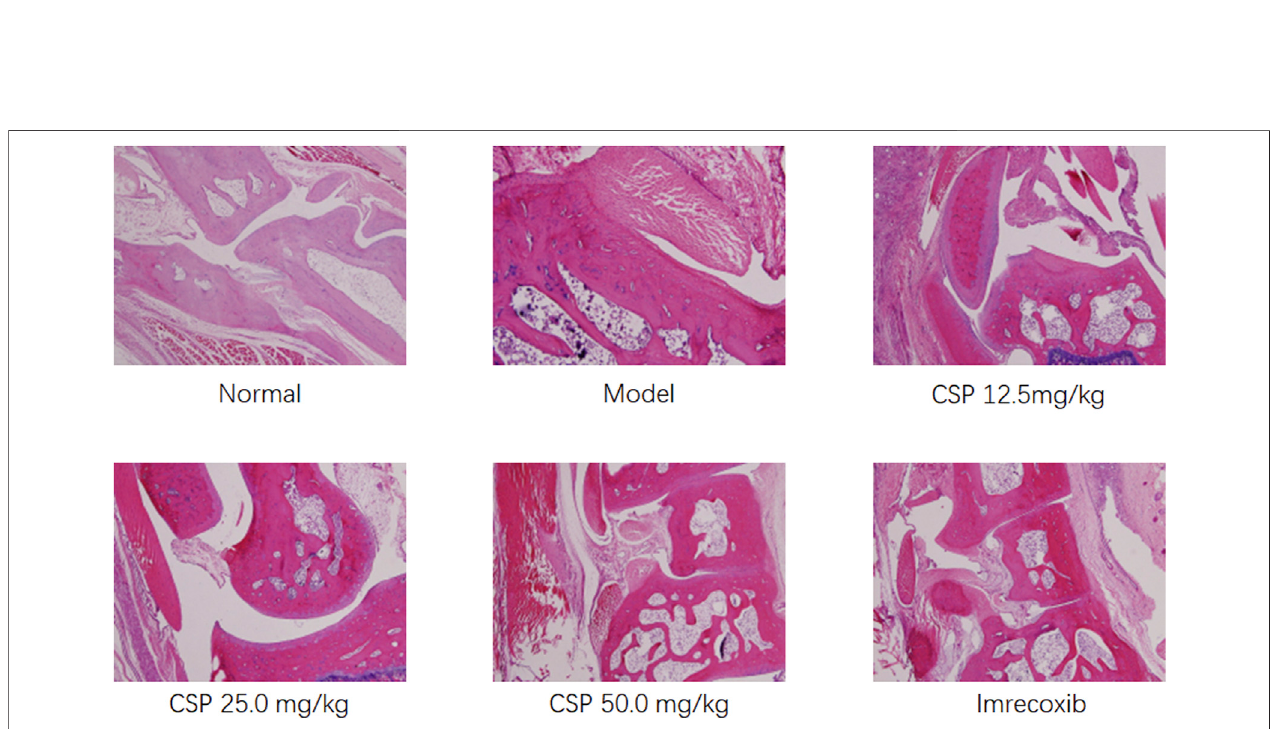
FIGURE 4 | Effects of CSP on the histologic changes in CFA rats (×40).